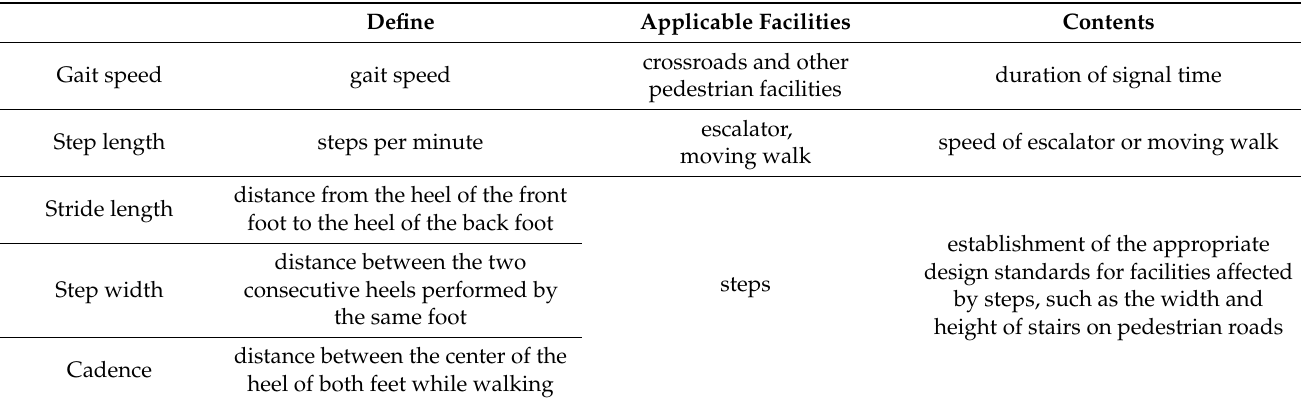
Table 10. Applications of the standard gait model by